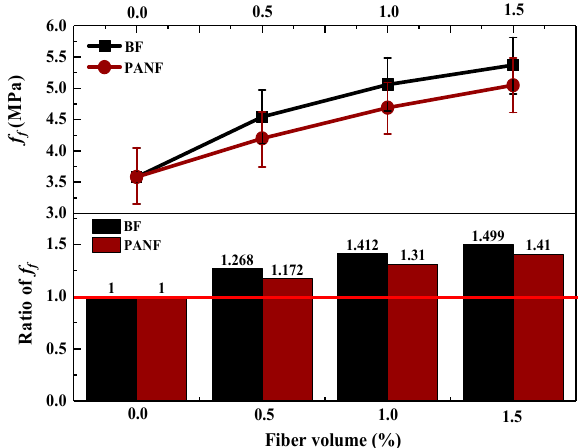
Figure 9. E ff ect of fibers on flexural strength of LWACs. Figure 9. Effect of fibers on flexural strength of LWACs.